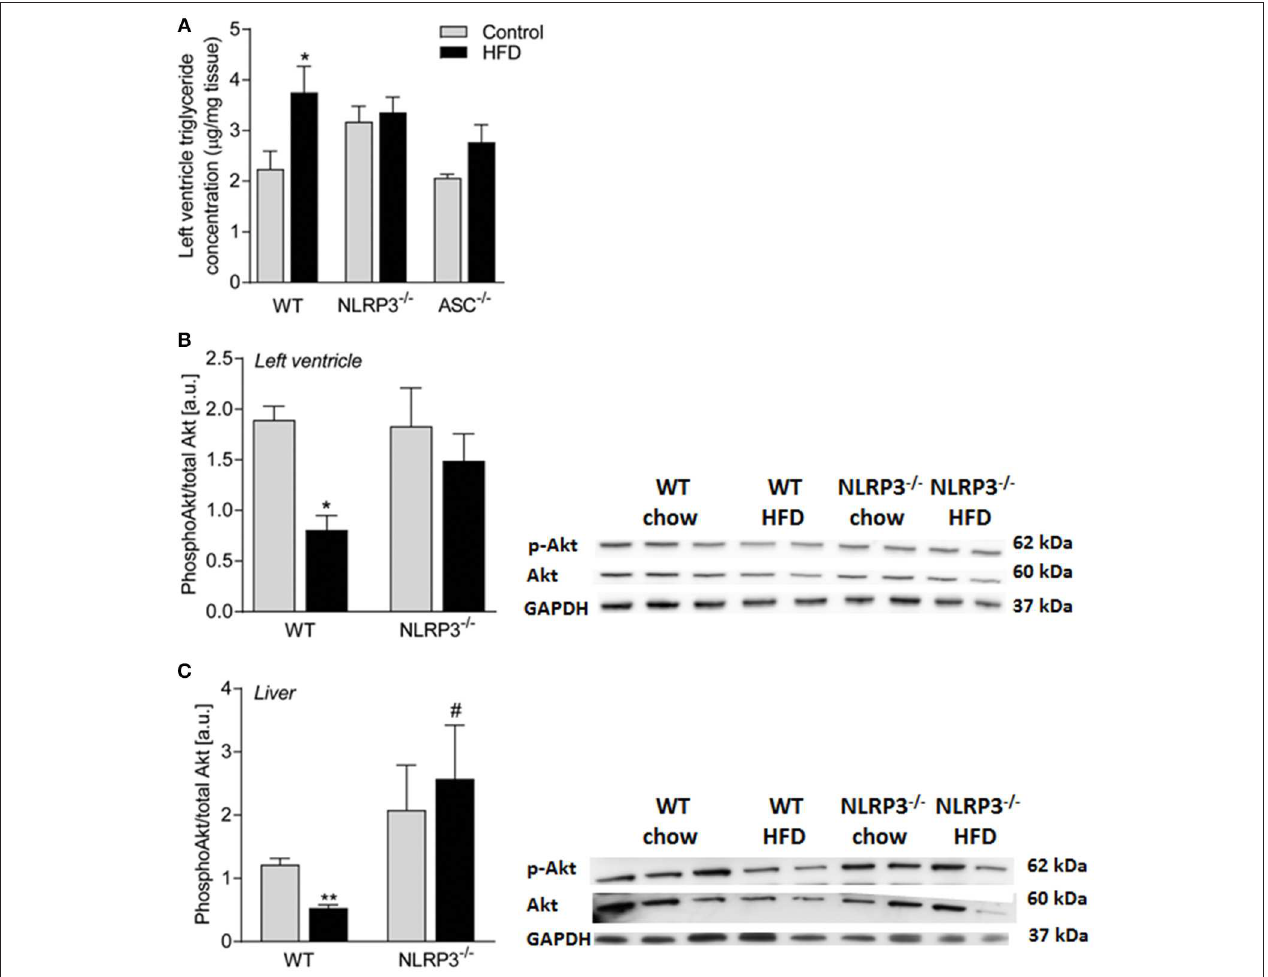
FIGURE 7 | Cardiac insulin sensitivity is preserved in obese NLRP3 deficient mice. WT, and Nlrp3 − / − male mice were exposed to high fat diet (HFD; 60 cal% fat) or control diet for 52 weeks. (A) Left ventricle concentration of triglycerides [WT: Control, n = 10; HFD, n = 10, Nlrp3 − / − : Control, n = 7; HFD, n = 7, and, Asc − / − ( Pycard − / − ): Control, n = 7; HFD, n = 7]. WT and Nlrp3 − / − mice on control diet or HFD for 52 weeks were fasted for 4h and received an i.p. injection of insulin (2 IU/kg). Mice were euthanized and after 10min heart and liver were extirpated. Ratio of phosphorylated (Ser473) Akt to total Akt in mice on control diet or HFD in (B) left ventricle and (C) liver (WT: Control, n = 6; HFD, n = 4, Nlrp3 − / − : Control, n = 4; HFD, n = 4) were determined by immunoblot analysis. Data are normalized to corresponding GAPDH. Data are shown as mean ± SEM. * P < 0.05, ** P < 0.01 vs. control diet; # P < 0.05 vs. WT-HFD as determined by two-way ANOVA and Tukey’s multiple comparisons